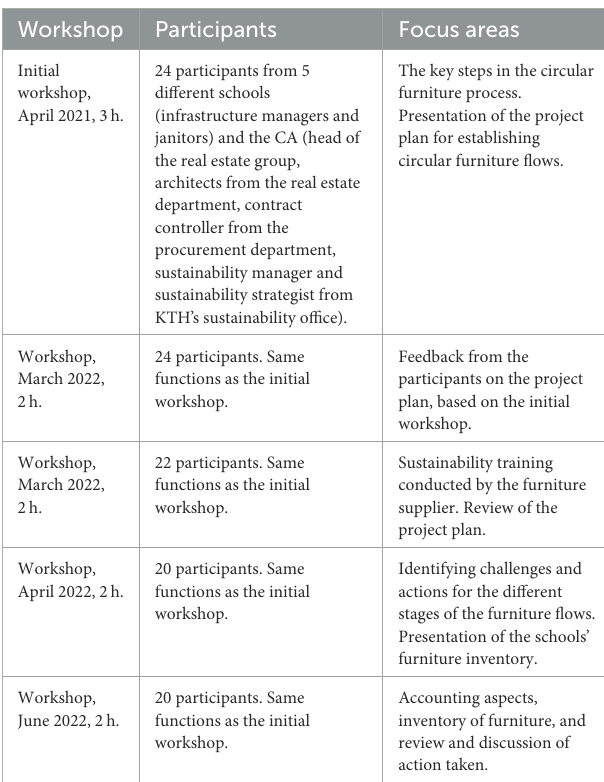
TABLE 1 Overview of the workshops, including participants and focus